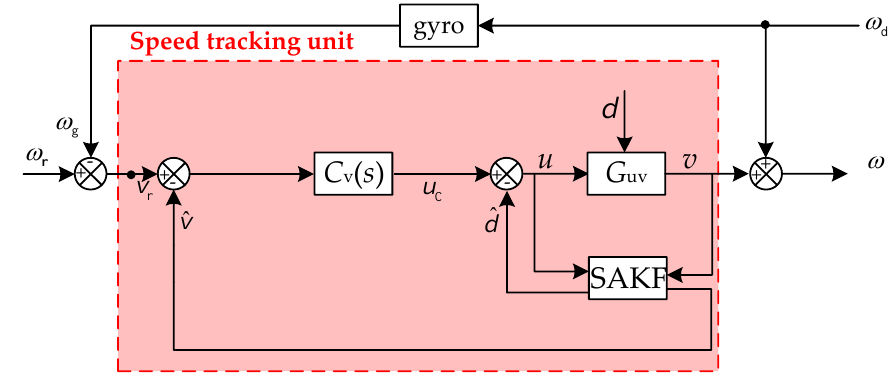
Figure 3. Schematic diagram of the proposed control method.